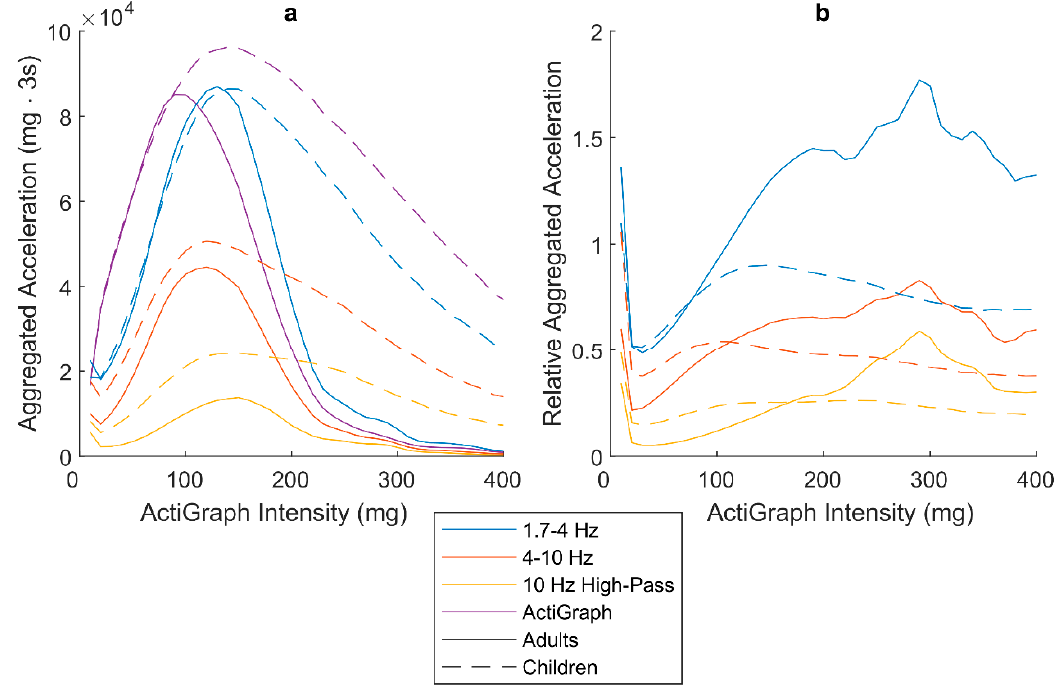
Figure 3. ( a ) Absolute aggregated three-second samples of acceleration from the sub-bands. ( b ) Aggregated acceleration relative to the ActiGraph filter.